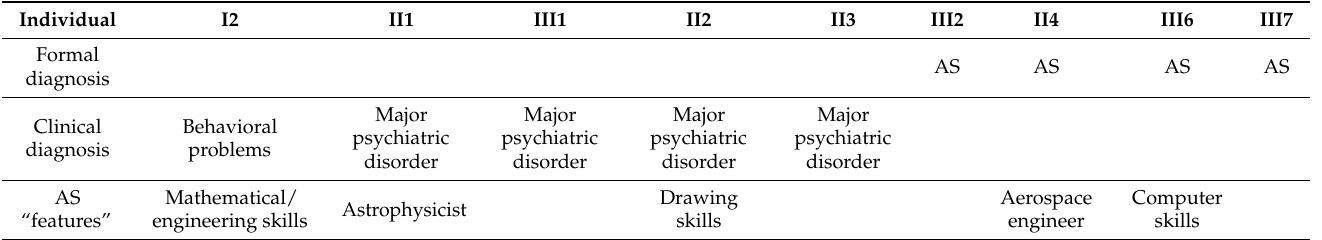
Table 1. Clinical description of the individuals of this family. We differentiated a formal AS diagnosis from a clinical diagnosis of a major psychiatric disorder. The “high-functioning side” of the AS syndrome was indicated as AS “features”.